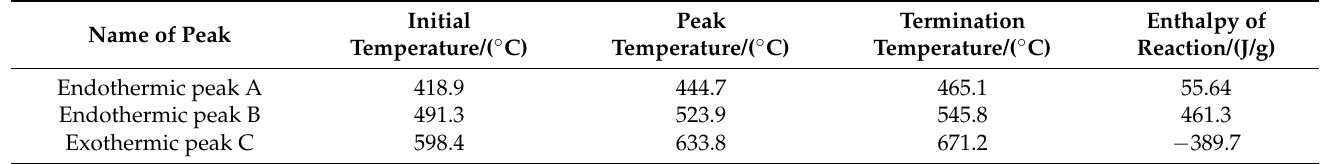
Figure 14. TG/DSC curves of Al/TiH 2 pyrolysis. A and B: Endothermic peak; C: Exothermic peak. Table 13. Parameters of peak A, peak B and peak C on DSC curve of Al/TiH 2 .